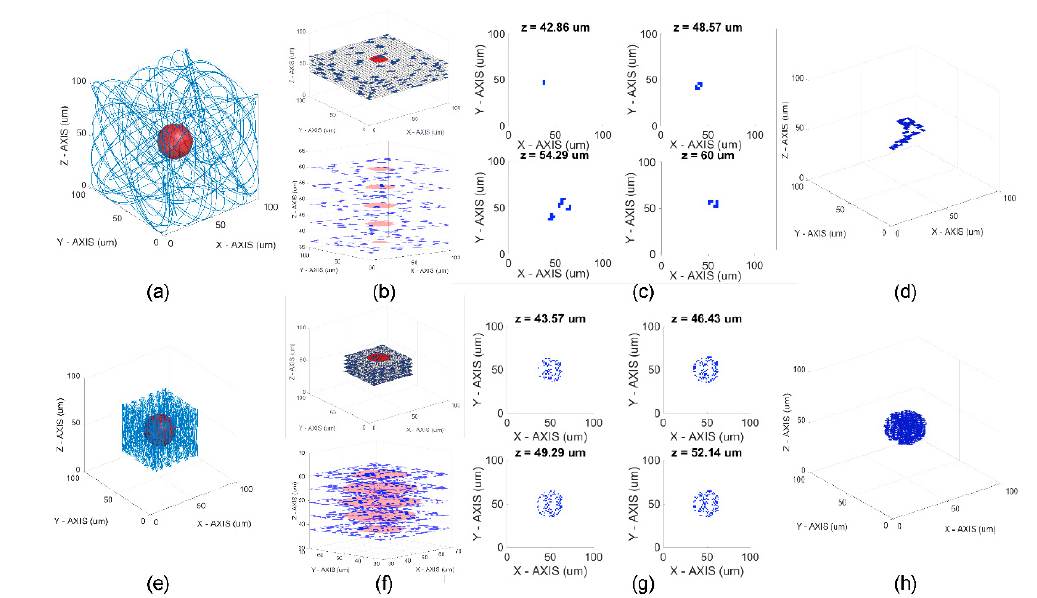
Figure 3. 3D Lissajous scan of a spherical solid with a radius of 15 μ m within a volume of 100 μ m × 100 μ m × 100 μ m for slow scan ( a ) and within a volume of 50 μ m × 50 μ m × 50 μ m for fast scan ( e ). Demonstration of z axis slices for slow ( b ) and fast scan ( f ). Detected pixels of five different slices for slow ( c ) and fast scan ( g ). Reconstructed image for slow ( d ) and fast scan ( h